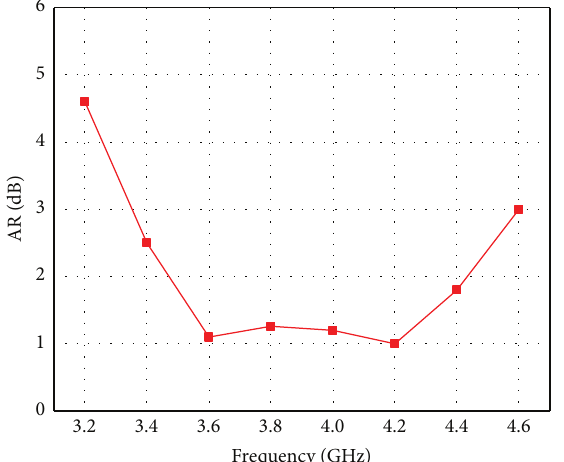
Figure 11: Measured LHCP gain versus frequency.